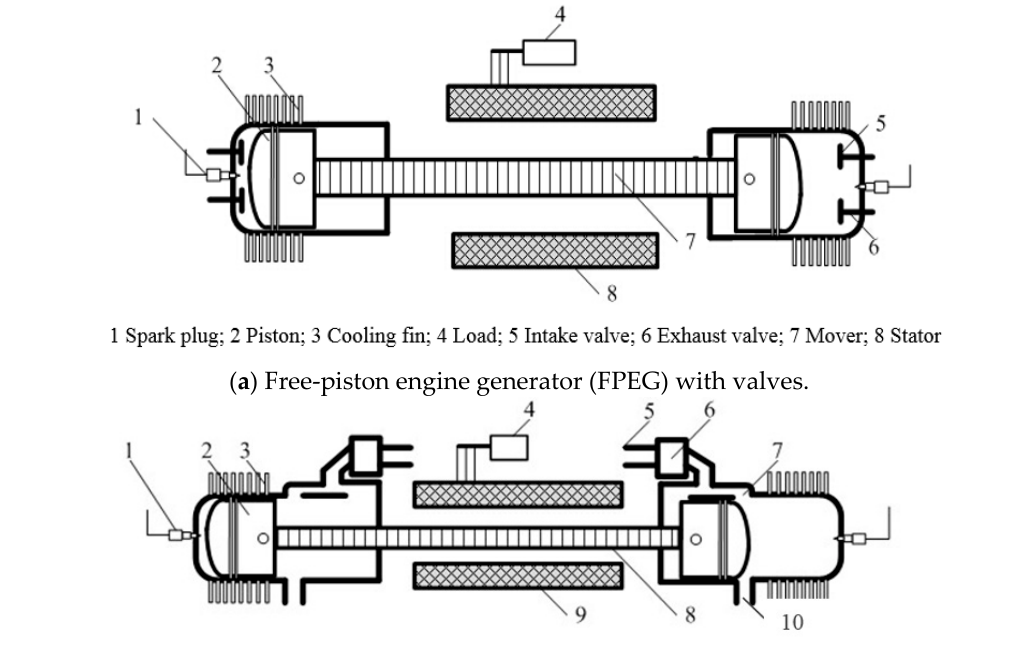
Figure 1. FPEG schematic configuration [3].